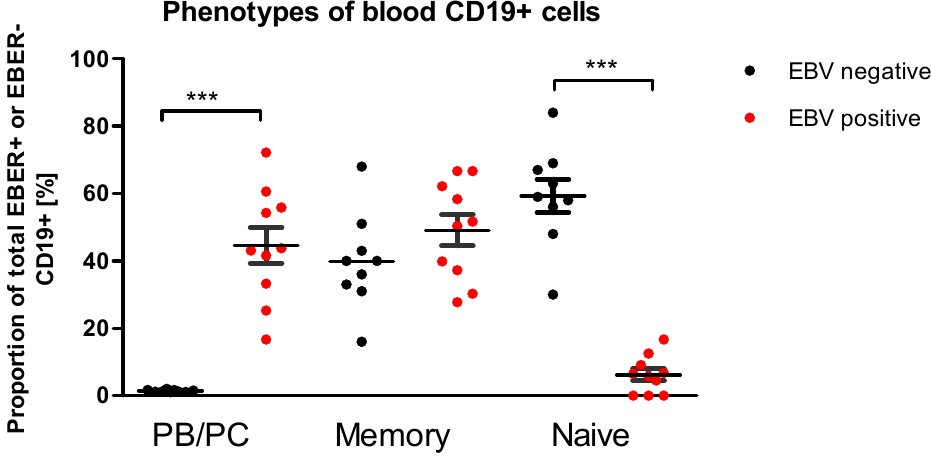
Fig. 1. Proportion of naïve and memory B cells and PB/PC in peripheral blood are different for EBV-infected and uninfected cells.